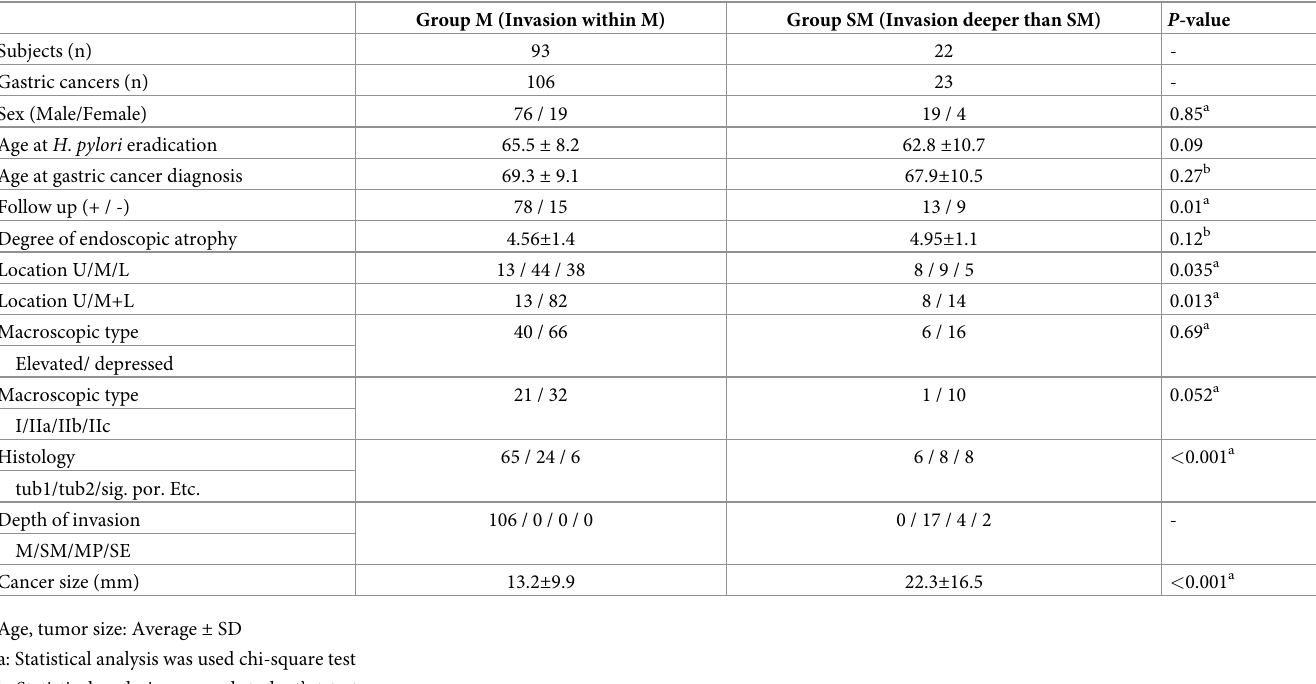
Table 4. Comparison between gastric cancer with mucosal invasion and with deeper than submucosal invasion after H . pylori